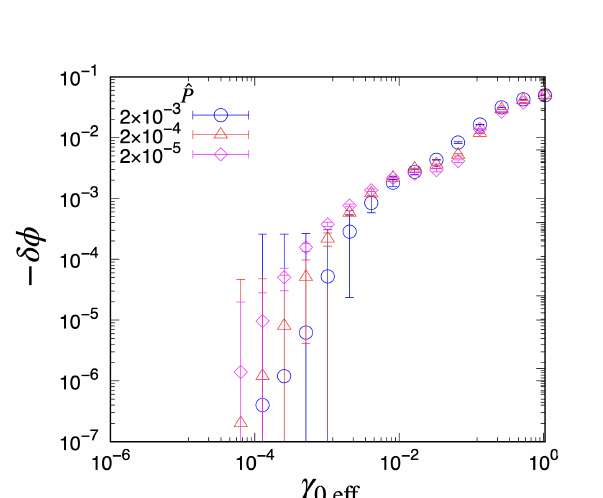
Figure 3. Plots of (cid:14)ϕ max against (cid:22) for various ˆ P .